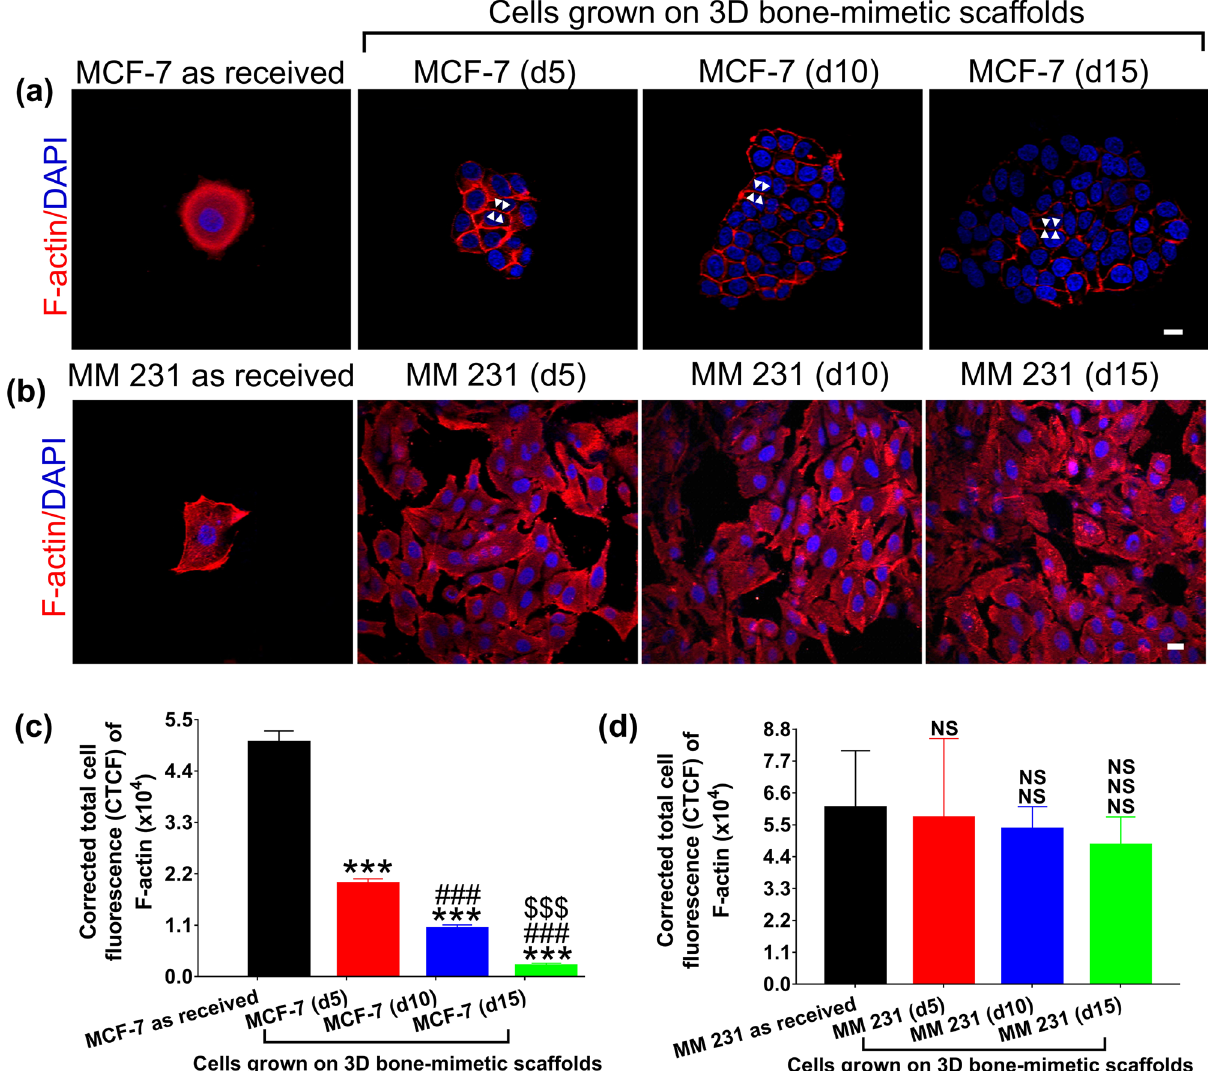
Figure 5. Representative immunofluorescence images showing distribution of F-actin in (a) MCF-7 as received and MCF-7 cells grown on 3D bone-mimetic scaffolds. Scaffolds grown MCF-7 formed an F-actin band (shown by white arrows) between adjacent cells; (b) MM 231 as received and MM 231 cells grown on 3D bone-mimetic scaffolds. Scaffolds grown MM 231 neither formed an F-actin band between adjacent cells nor stress-fibers. Scale bars: 10 µm. Quantification of corrected total cell fluorescence (CTCF) of F-actin for (c) MCF-7 as received and MCF-7 cells grown on 3D bone-mimetic scaffolds; (d) MM 231 as received and MM 231 cells grown on 3D bone-mimetic scaffolds. For each measured sample, at least 5–6 cells were measured. Data are reported as a mean ± standard deviation (SD).*p < 0.05, **p < 0.01, and ***p < 0.001 indicate significant difference between as received and 3D bone-mimetic scaffolds-grown breast cancer cells; # p < 0.05, ## p < 0.01, and ### p < 0.001 indicate significant difference between scaffolds-grown breast cancer cells (d5), and other scaffolds-grown breast cancer cells (i.e., (d10) and (d15)); $ p < 0.05, $$ p < 0.01, and $$$ p < 0.001 indicate significant difference between scaffolds- grown breast cancer cells (d10) and